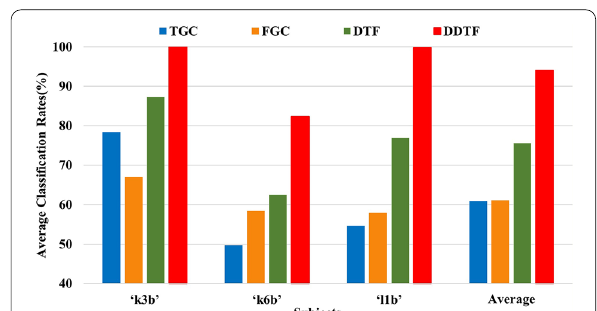
Fig. 14 Comparison of average classification rates with GC-based BFN methods on Dataset